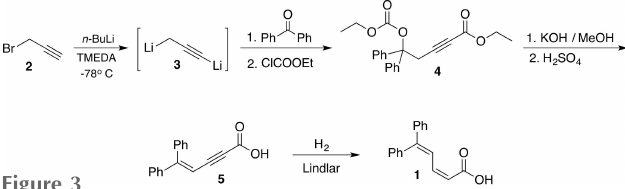
Figure 3 A synthetic scheme for the preparation of the title compound.